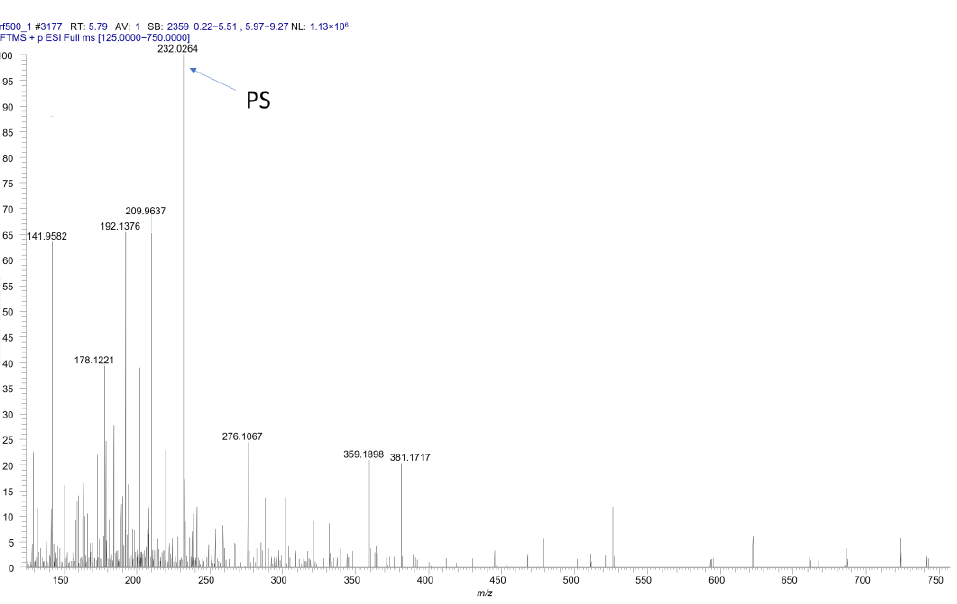
Figure A4. HRMS spectrum of paracetamol sulphate generated in rat small intestine luminal after 90 min of perfusion.